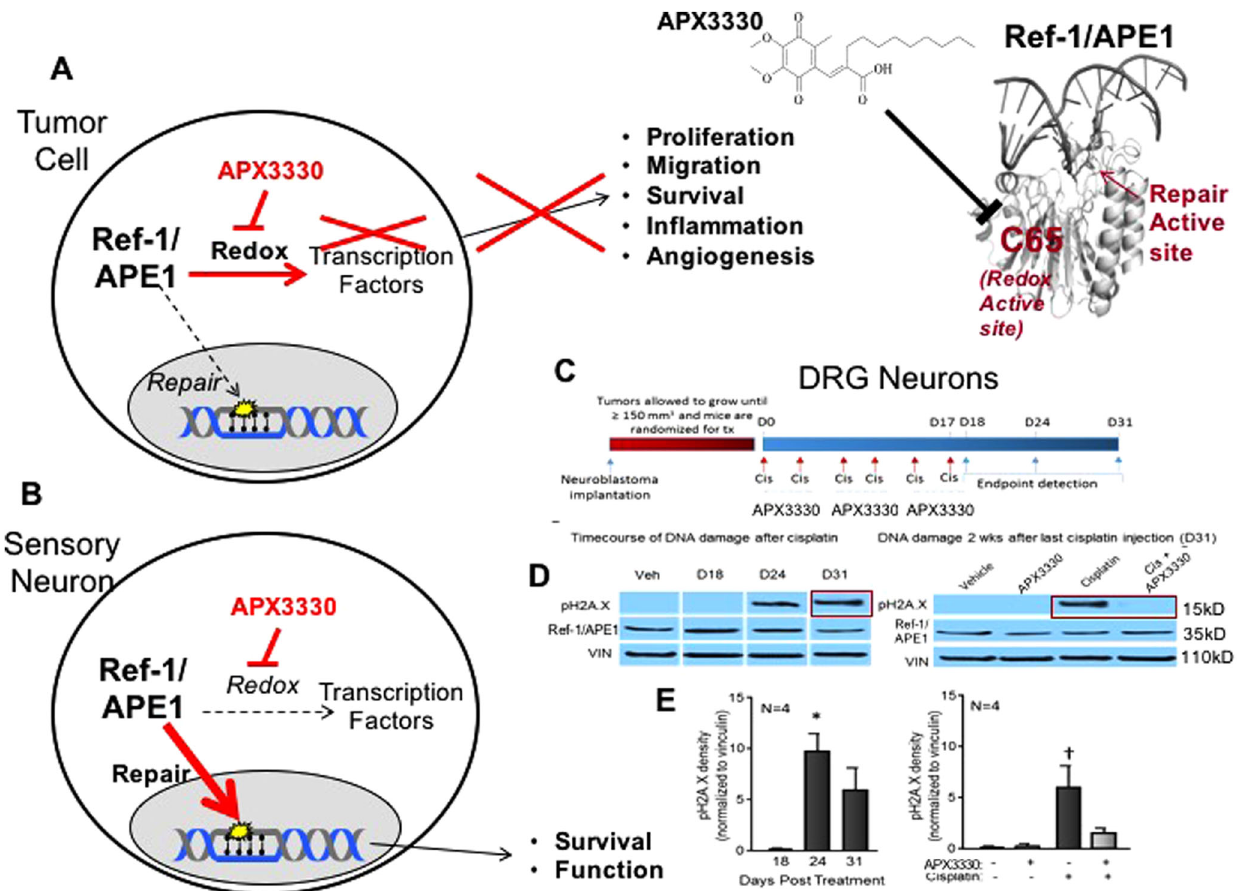
Fig. 6 Differential role of Ref-1/APE1 redox inhibition in sensory neurons vs. tumor cells. a In tumor cells, Ref-1/APE1 redox inhibition as multiple downstream effects on tumor growth, survival, migration and tumor in fl ammation. 31, 106, 253, 254, 257 b In sensory neuron cells such as DRG neurons, the addition of APX3330 does not have a negative effect on the cells, and promotes survival and functional protection through enhancement of Ref-1/APE1 DNA repair activity against oxidative DNA damaging agents (e.g., cisplatin, oxaliplatin) that invoked the DNA BER pathway. In the lower right panel , APX3330 attenuates neurotoxicity induced by systemic administration of cisplatin to tumor-bearing mice. c Treatment paradigm for investigation of the effects of cisplatin and APX3330 on DNA damage within DRG. Neuroblastoma cells were implanted subcutaneously into the right fl anks of 6-week-old male NSG mice and allowed to proliferate until tumor volumes ≥ 150 mm 3 . Mice were then randomized for treatment with cisplatin ± APX3330 treatment. Cisplatin and APX3330 were administered concurrently for 3 weeks (Day 0 – Day 17) and endpoints of neuronal toxicity were assessed within the DRG of mice at several time points following the last dose of cisplatin. d Representative blots demonstrating pH2A.X immunoreactivity at D24 and D31. e Quanti fi cation of pH2A.X immunoreactivity. An asterisk indicates statistical signi fi cance between D18 and D24 ( e ) as determined by a one-way ANOVA with Tukey ’ s post test with p < 0.05. A cross indicates statistical signi fi cance between Veh/Veh group and the Veh/Cis group ( e ) as determined by a two-way ANOVA with Bonferroni ’ s posttest with p <